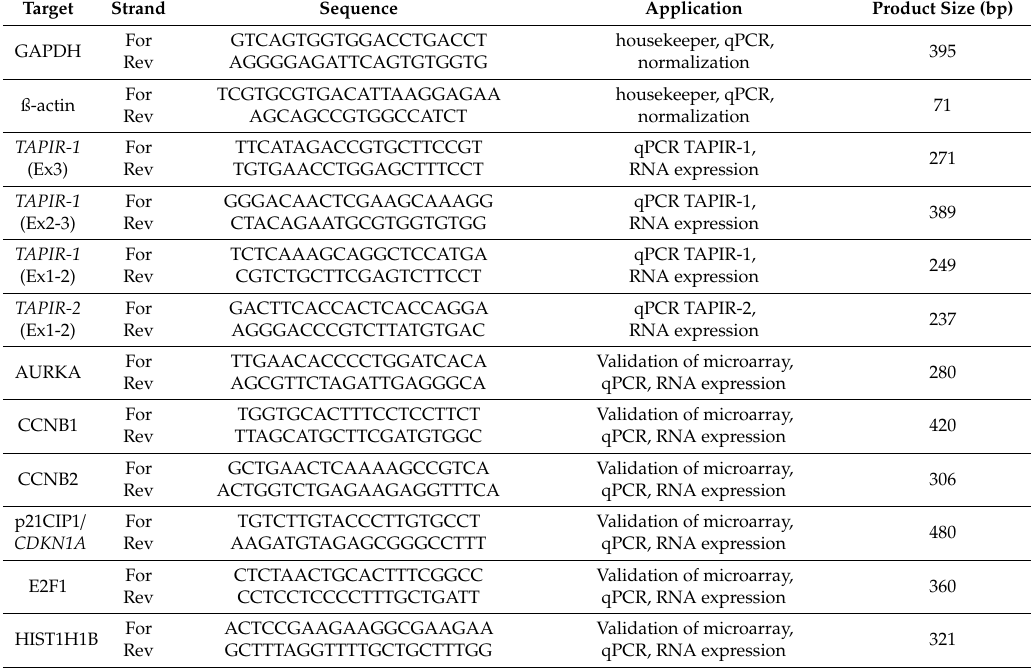
Table 2. List of oligonucleotides used in the